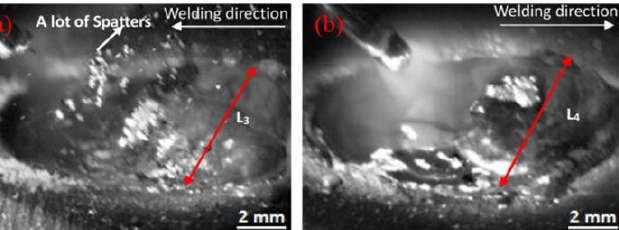
Figure 12. The dynamic behavior of weld pools: ( a ) ALHW; ( b ) LAHW [69]. Reprinted with permission from [69] 2018 Elsevier.